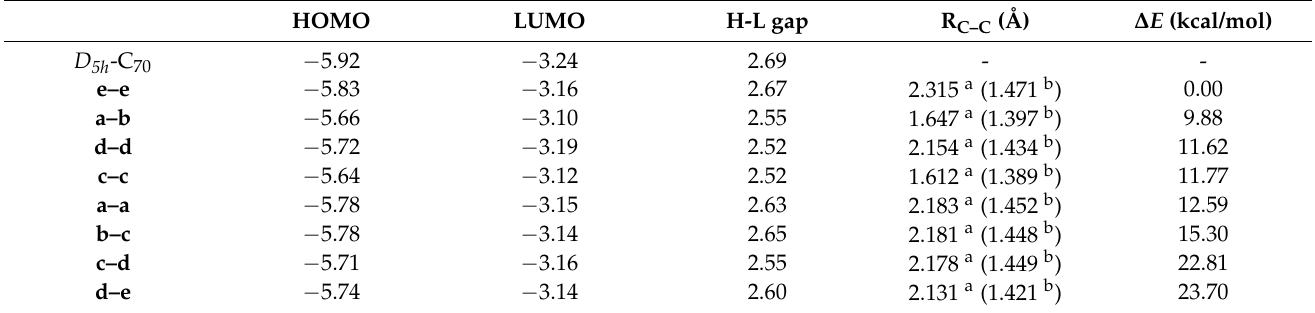
Table 1. DFT calculation results of C 71 H 2 isomers and D 5h -C 70 at the B3LYP/6-31G(d,p) level. HOMO LUMO H-L gap